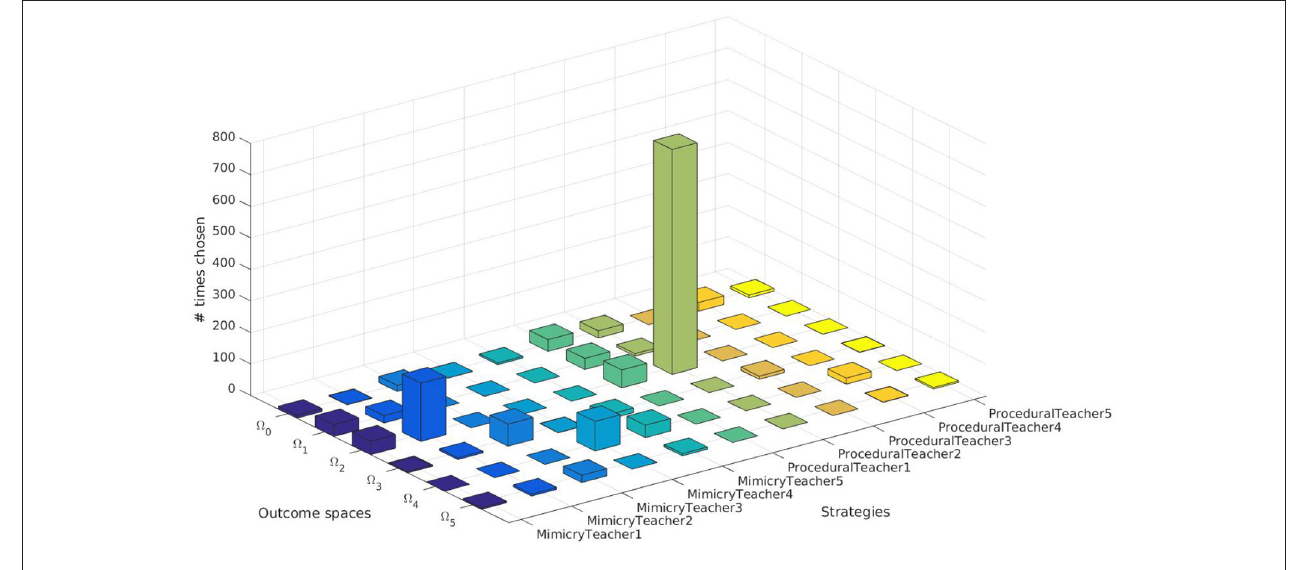
FIGURE 6 | Choices of teachers and target outcomes of the SGIM-PB learner.